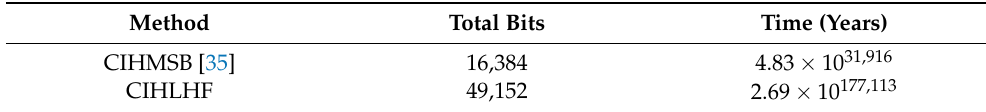
Table 4. Security comparison of CIHMSB and